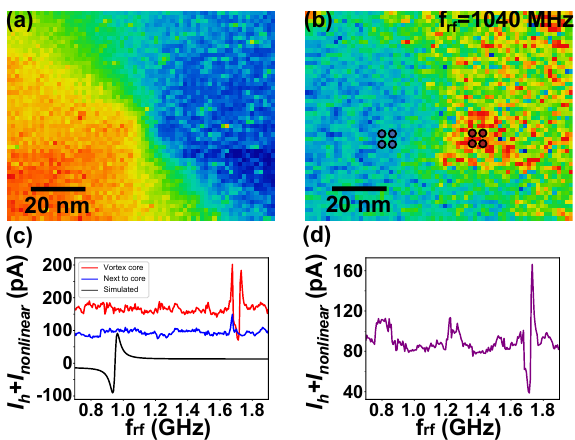
Figure 5. ( a ) dI / dU map of the vortex core area ( I t = 10 nA, U 0 = − 400 mV, U mod = 50 mV) and ( b ) the corresponding map of the supplementary current at frequency f rf = 1040 MHz ( I t = 20 nA, = 15 mV); ( c ) Supplementary current as a function of rf frequency measured in two U 0 = 5 mV, U t rf different areas of ( b ) indicated by blue (next to vortex core) and red (vortex core) dots and simulated homodyne current (black); ( d ) Normalized supplementary current on the vortex